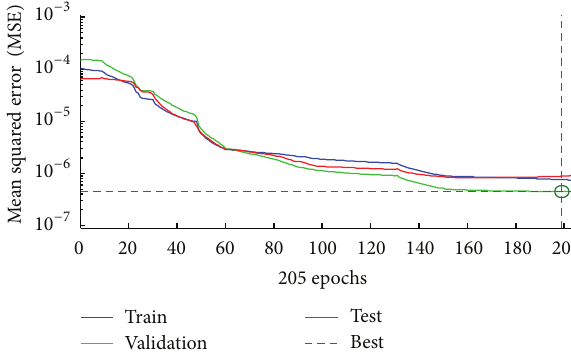
Figure 11: The training performance for FFBP with 10